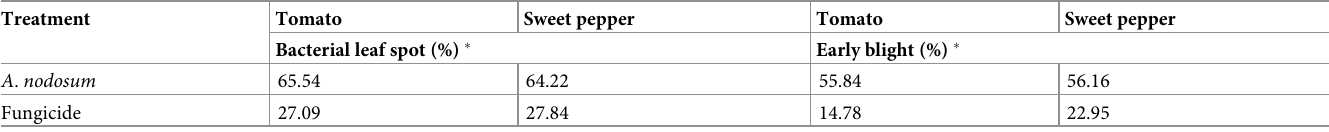
Table 1. Effect of A . nodosum extract on reduction of disease severity in greenhouse-grown tomato and sweet pepper. Treatment